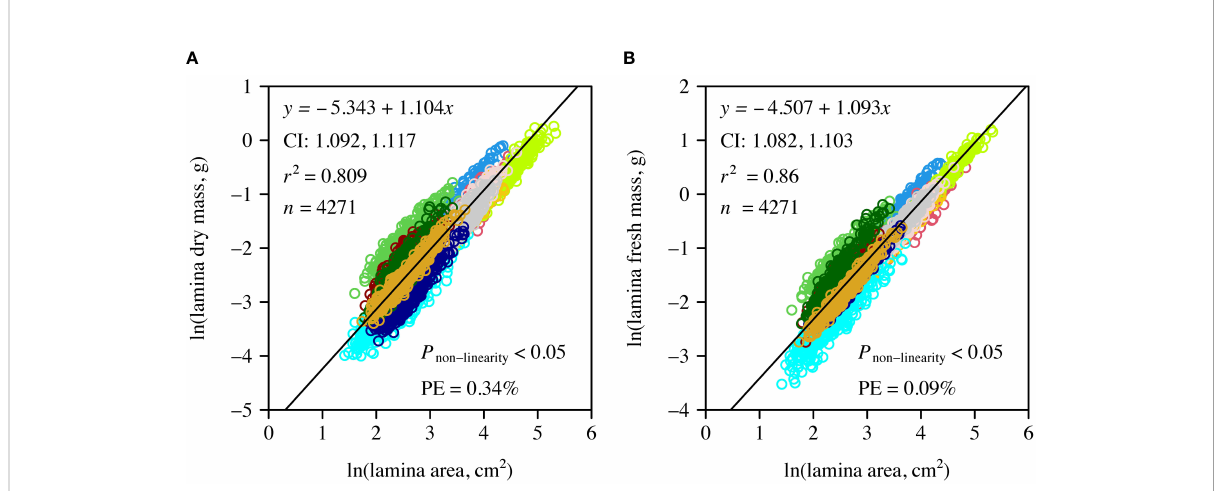
FIGURE 3 Log-log bivariate plots and linear fi ts to leaf dry mass vs. A (A) , and to leaf fresh mass vs. A (B) for the pooled data of the 12 species. Open circles are the observed data; the straight lines are the log-log regression curves.